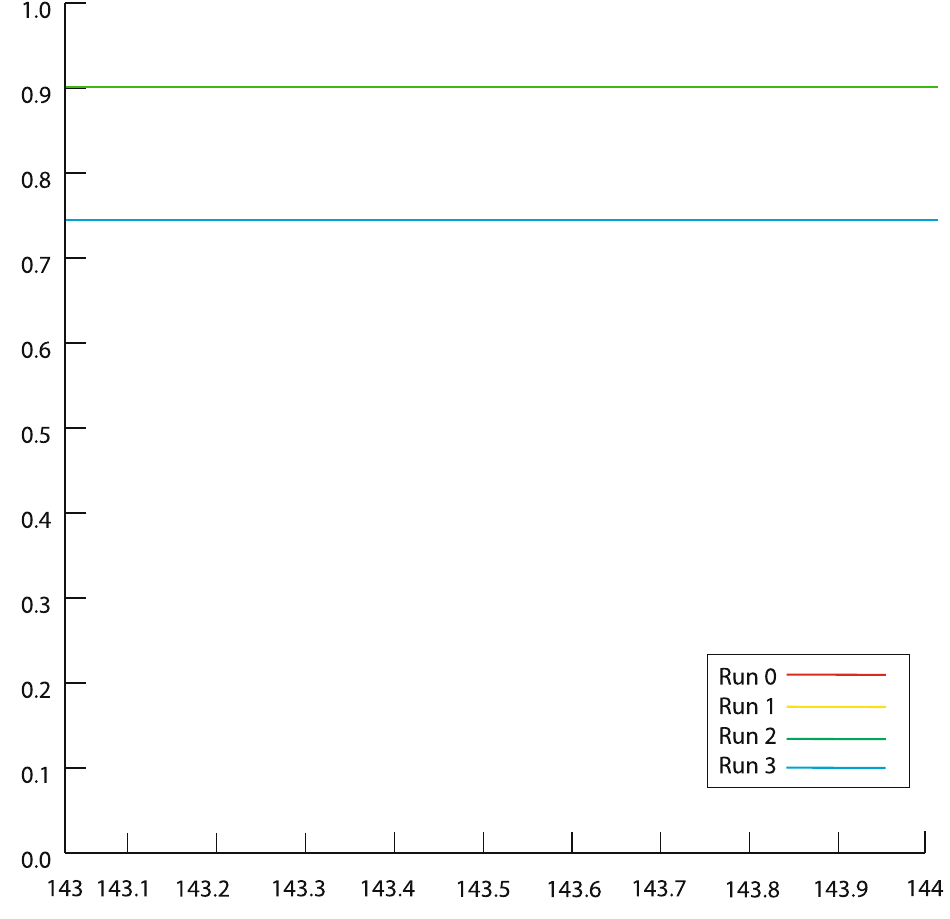
Figure 4. Admission section efficiency in a different run in the admission